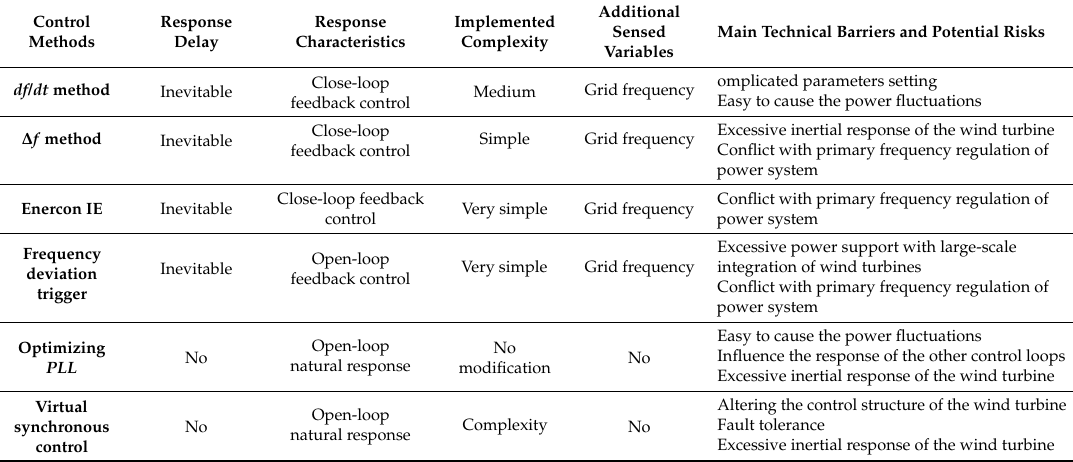
Table 2. Major characteristic of the wind turbine’s main inertia